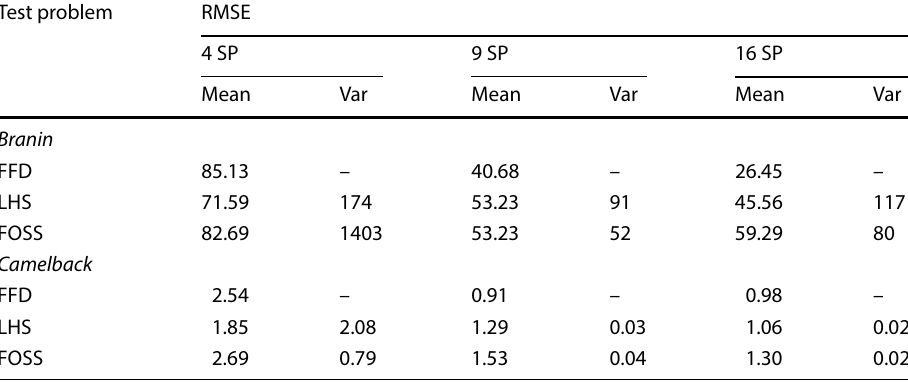
Table 2 Average RMSE for a DACE surrogate based on FFD, LHS and FOSS with 4, 9 and 16 sampling points